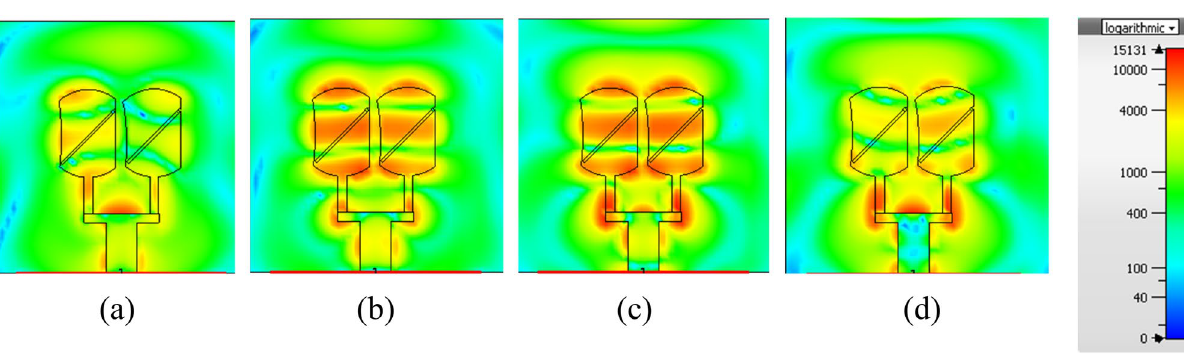
Figure 6. Variations of the E-field vs. various phases ( a ) 0°, ( b ) 90°, ( c ) 135°, ( d ) 180°.